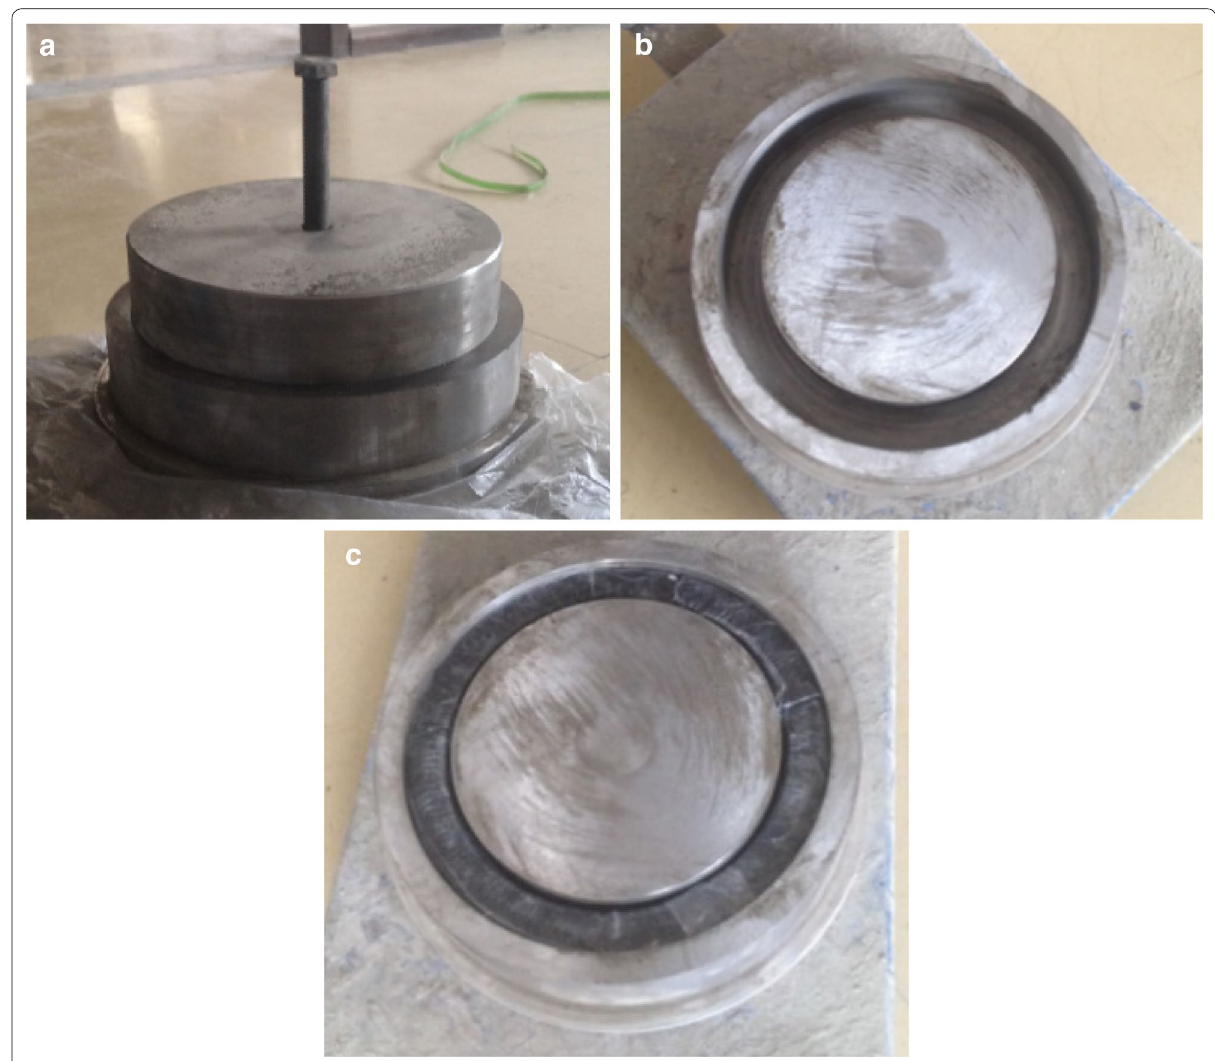
Fig. 2 Device of lateral confinement